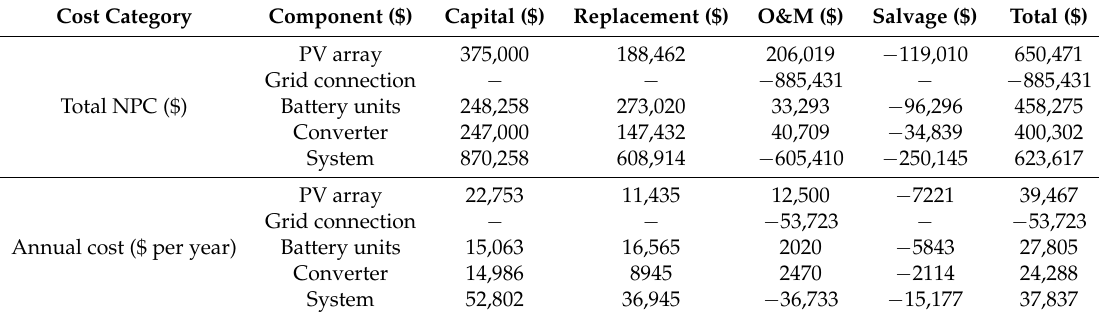
Table 5. Costs of the suggested energy system configuration for